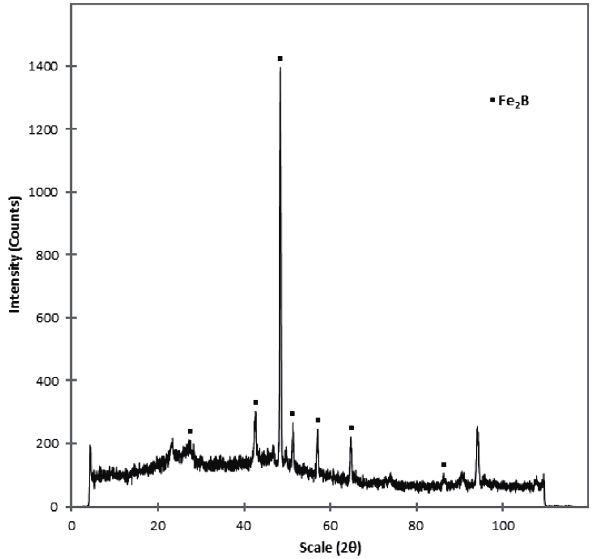
Fig. 6: XRD pattern obtained at the surface of the borided AISI 1026 steel at 1273 K during 8 h of treatment.